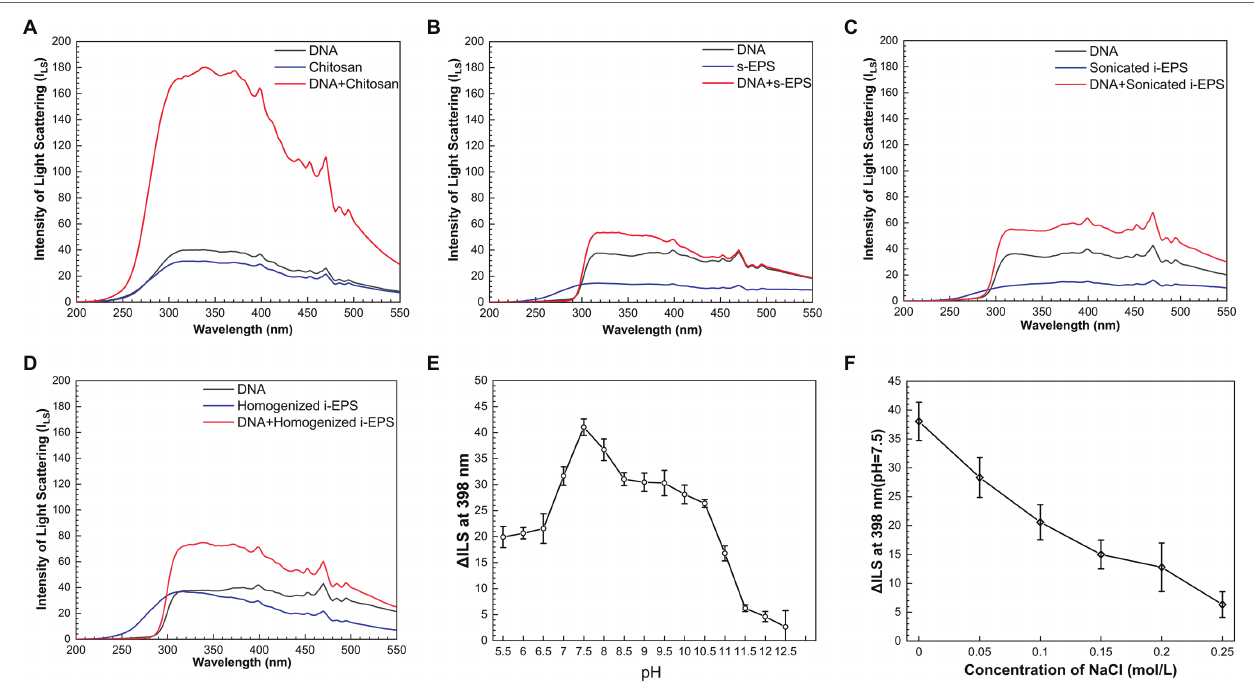
FIGURE 4 | Resonance light-scattering analysis of the interaction between DNA and exopolysaccharides (EPS). The light scattering spectra of chitosan (A) , s-EPS (B) , sonicated i-EPS (C) , homogenized i-EPS (D) , and their complex with DNA were detected by fluorescence spectrometer with synchronous scanning in the range of 200–550 nm. The effects of different pH (E) and NaCl concentrations (F) on the changed value of light scattering spectra intensity ( Δ I LS ) of DNA-homogenized i-EPS complex were measured at 398 nm ( n = 3). I LS , the intensity of light